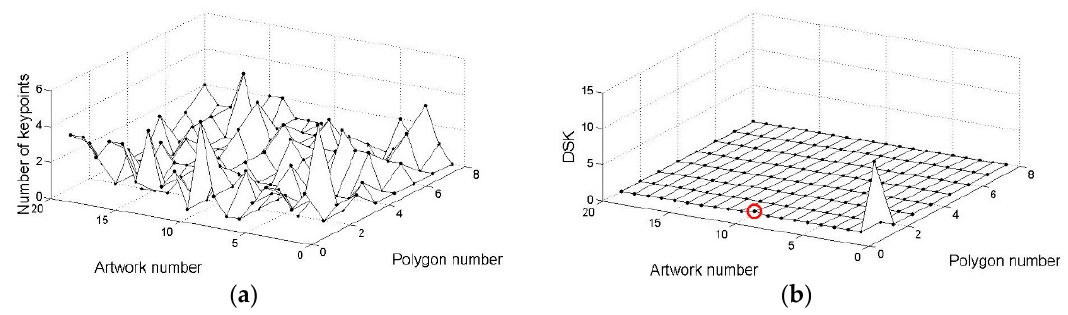
Figure 17. Number of matched features and the DSK for the artwork Mona Lisa . ( a ) Number of matched features; ( b ) DSK.